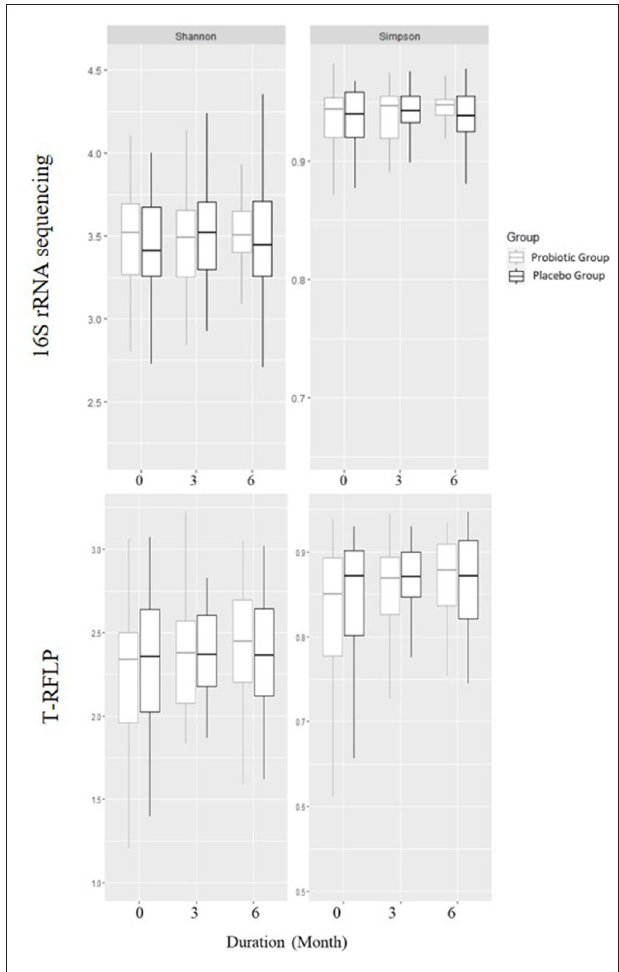
FIGURE 1 | Alpha diversities using Shannon and Simpson’s diversity indexes based on 16S rRNA gene sequencing and T-RFLP in children receiving either a mixture of Lactiplantibacillus plantarum HEAL9 and Lacticaseibacillus paracasei 8700:2 (probiotic group) or maltodextrin (placebo